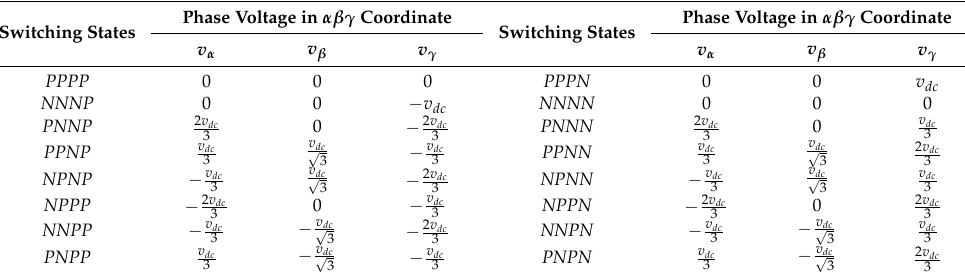
Table 2. The switching states with phase voltages in the αβγ